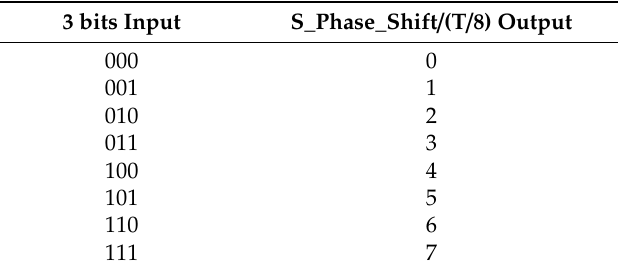
Table 1. Mapping table from bits to S_Phase_Shift value (Adapted from [30]). 3 bits